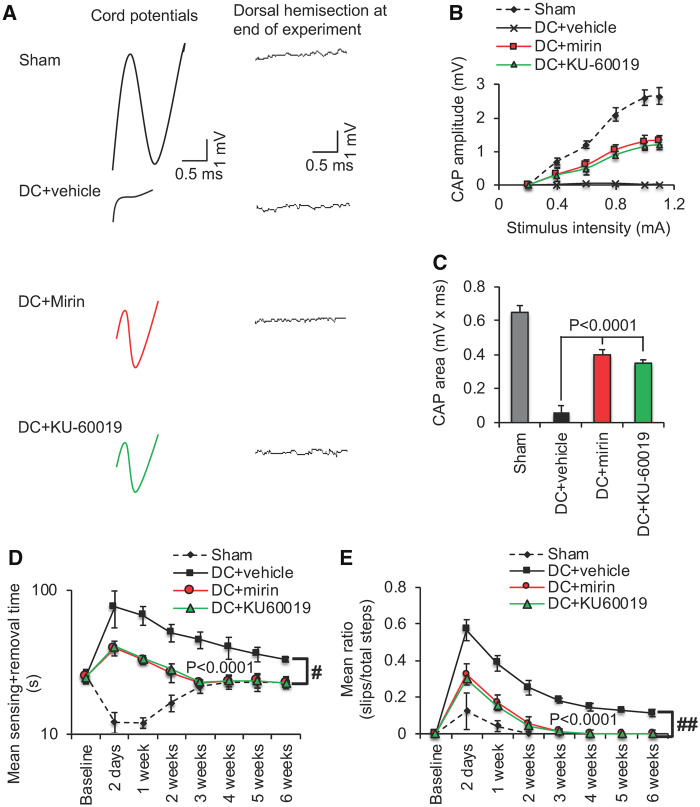

Intrathecal injection of Mre11 and ATM inhibitors promotes significant functional repair after SCI. (A) Spike 2 software processed CAP traces from representative sham controls, DC + vehicle, DC + mirin and DC+KU-60019-treated rats showing some recovery of dorsum cord potentials in mirin and KU-60019-treated rats. Dorsal hemisection between the stimulating and the recording electrodes at the end of the experiment ablated CAP traces in all animals demonstrating technical success of the experiment. (B) Negative CAP amplitudes were significantly attenuated in DC + vehicle-treated rats but were significantly improved in DC + mirin and DC+KU-60019-treated rats [P < 0.0001, one-way ANOVA (main effect)]. (C) Mean CAP area at different stimulation intensities were significantly attenuated in DC + vehicle-treated rats but improved significantly in DC + mirin and DC+KU-60019-treated rats (P < 0.0001, one-way ANOVA [main effect)]. (D) Mean tape sensing and removal time are restored to normal three weeks after treatment with mirin and KU-60019 (P < 0.0001, independent sample t-test, no post hoc test (DC + vehicle versus DC + mirin/DC+KU-60019 at 3 weeks) whilst a significant deficit remains in DC + vehicle-treated rats (#P < 0.00012, generalized linear mixed models over the whole 6 weeks). (E) Mean error ratio to show the number of slips versus total number of steps in the horizontal ladder walking test also returns to normal 3 weeks after treatment with mirin and KU-60019 (P < 0.0001, independent sample t-test, no post hoc test [DC + vehicle versus DC + mirin/DC+KU-60019 at 3 weeks)], with a deficit remaining in DC + vehicle-treated rats (##P < 0.00011, linear mixed models over the whole 6 weeks). n = 6 rats/treatment/test, three independent repeats (total n = 18 rats/treatment/test).